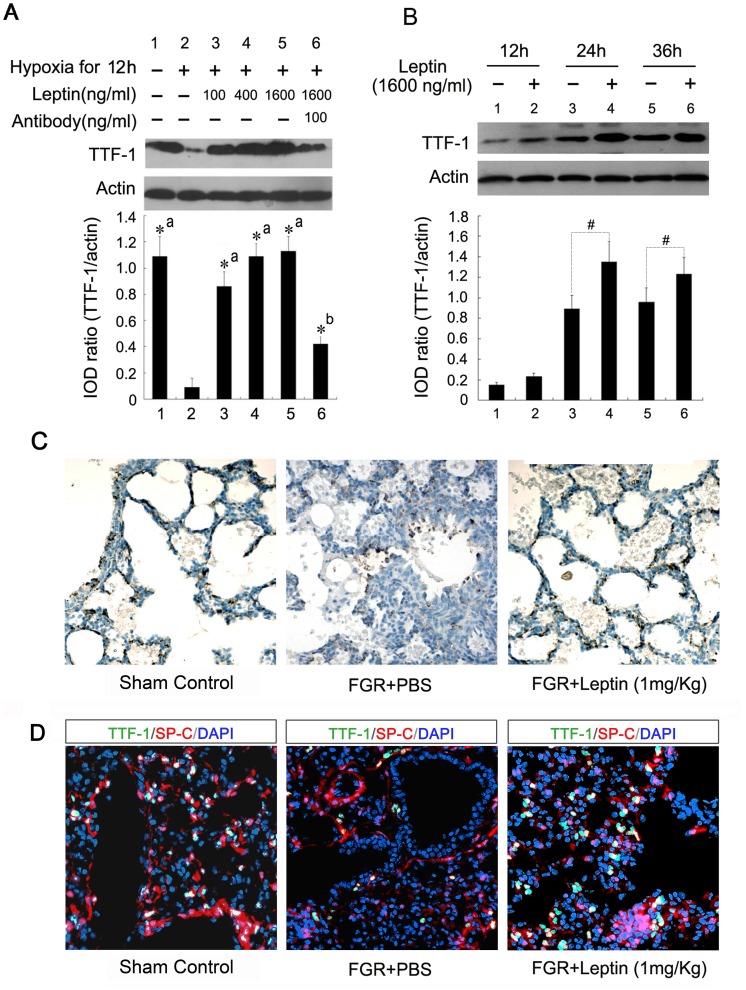
Effect of leptin on the expression of TTF-1 in fetal lungs and type-II AECs.A: Cultured type-II AECs were treated as above, and whole lysates were detected by immunoblotting with TTF-1 antibody. *P<0.01; a: vs the hypoxia-treated group, b: vs the 1600 ng/mL leptin-treated group (n = 3). B: Type-II AECs were exposed to hypoxia for 12 h and treated with 1600 ng/ml leptin for the indicated times. Protein levels were analyzed by immunoblotting. #P<0.05 vs the corresponding untreated cells (n = 3). C: Lung tissues from fetal rats at 21 days’ gestation were fixed and incubated with a monoclonal antibody against TTF-1, and visualized by diaminobenzidine color reaction (×200). TTF-1 was mainly expressed in the nuclei of AECs, and leptin markedly upregulated the expression of TTF-1 in the lungs of FGR fetuses. D: Immunofluorescent analysis with antibodies against TTF-1 (green) and SP-C (red) showed that TTF-1 mainly expressed in the type-II AECs and increased in fetal lungs of FGR rats with leptin treatment. Nuclei were stained with DAPI (blue) (×320).